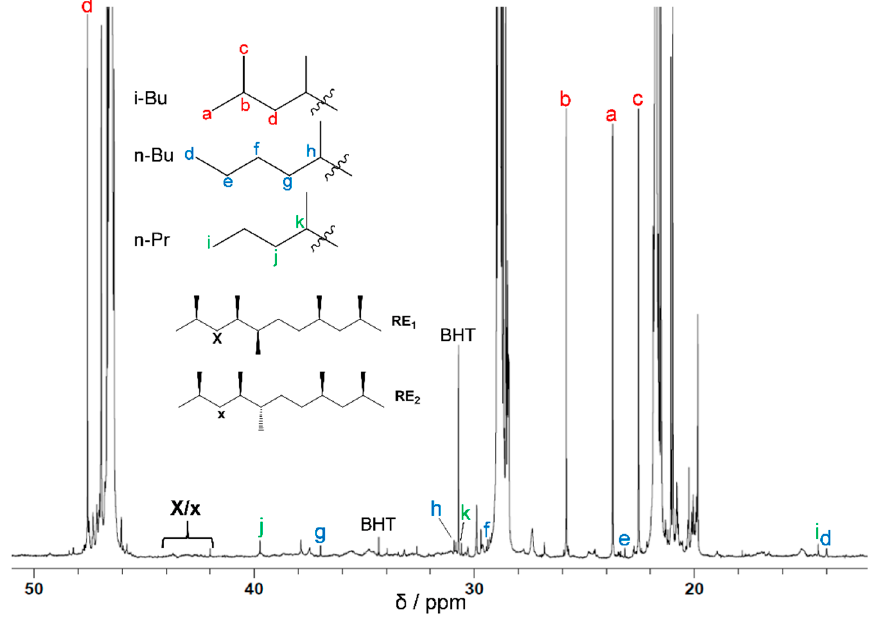
Figure 13. High-temperature (HT) 13 C cryo-probe NMR spectrum of a polypropylene (PP) sample obtained from LSF propylene polymerization at 0.06 s. Minor peaks arose from regioirregular sequences and chain ends of PP.